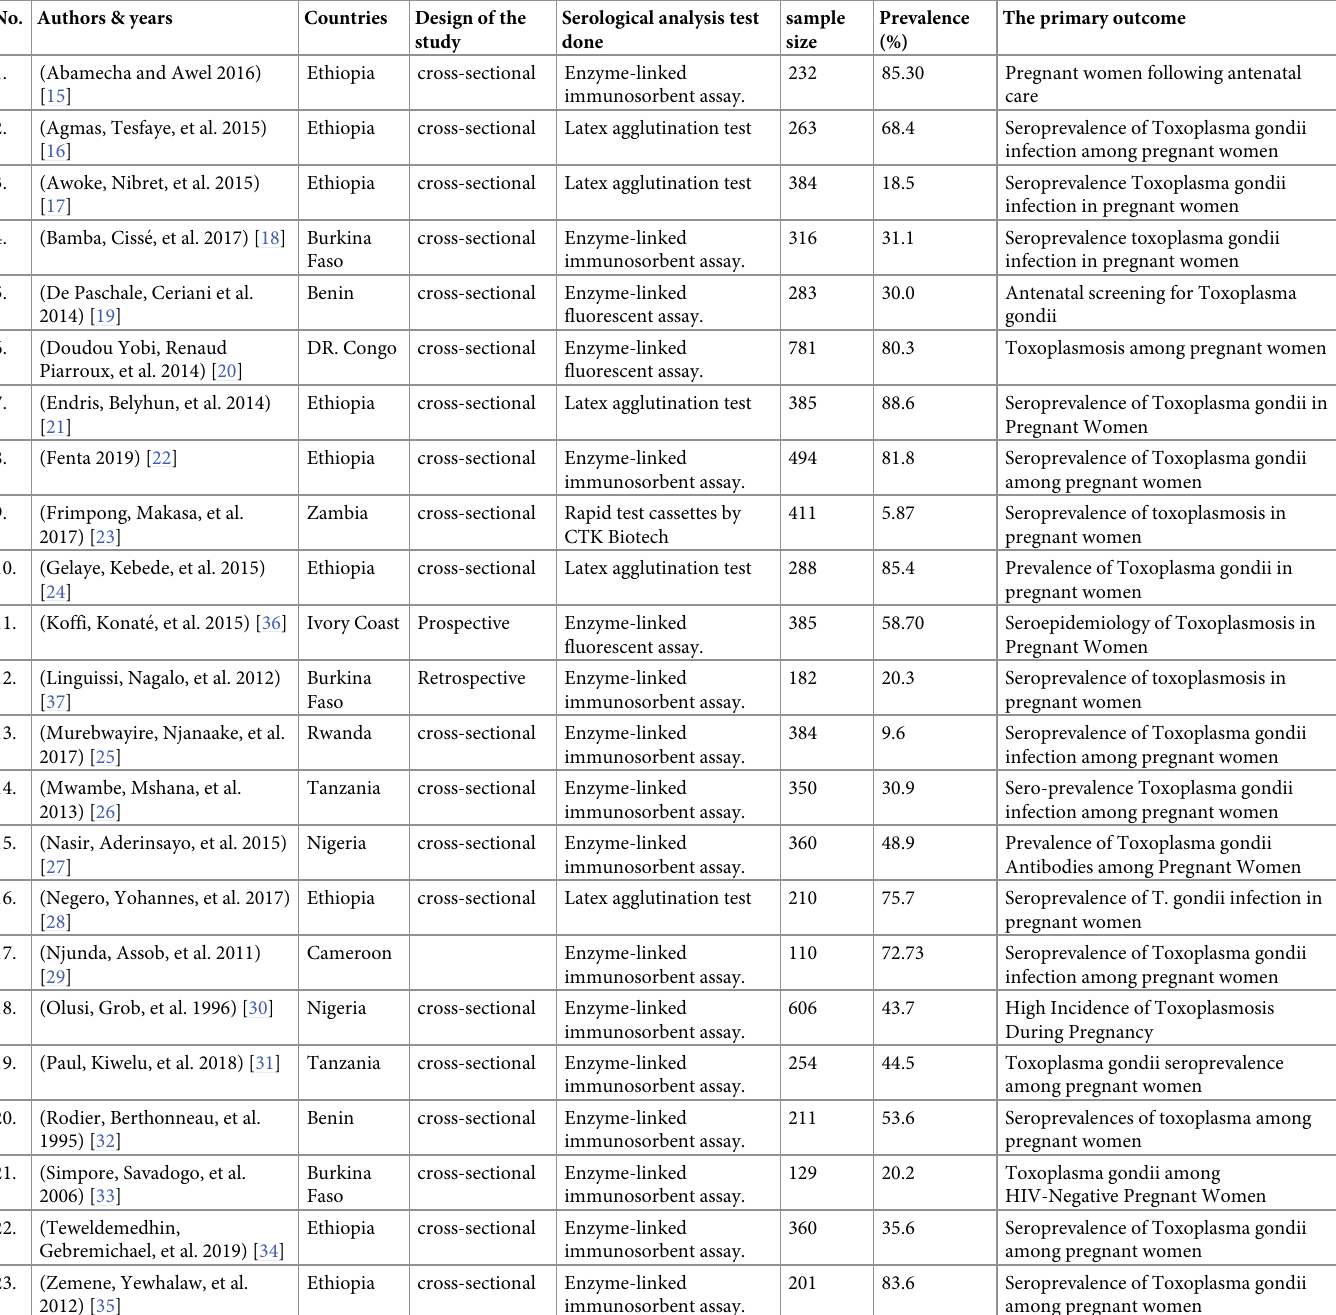
Table 1. Description of study participants and characteristics of studies included in the systematic review and